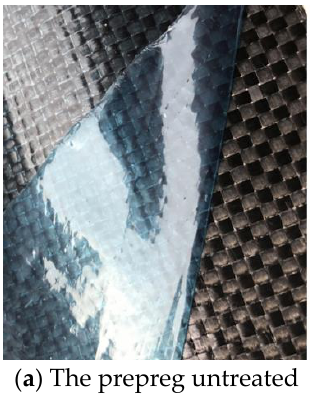
( a ) The prepreg untreated Figure 1.